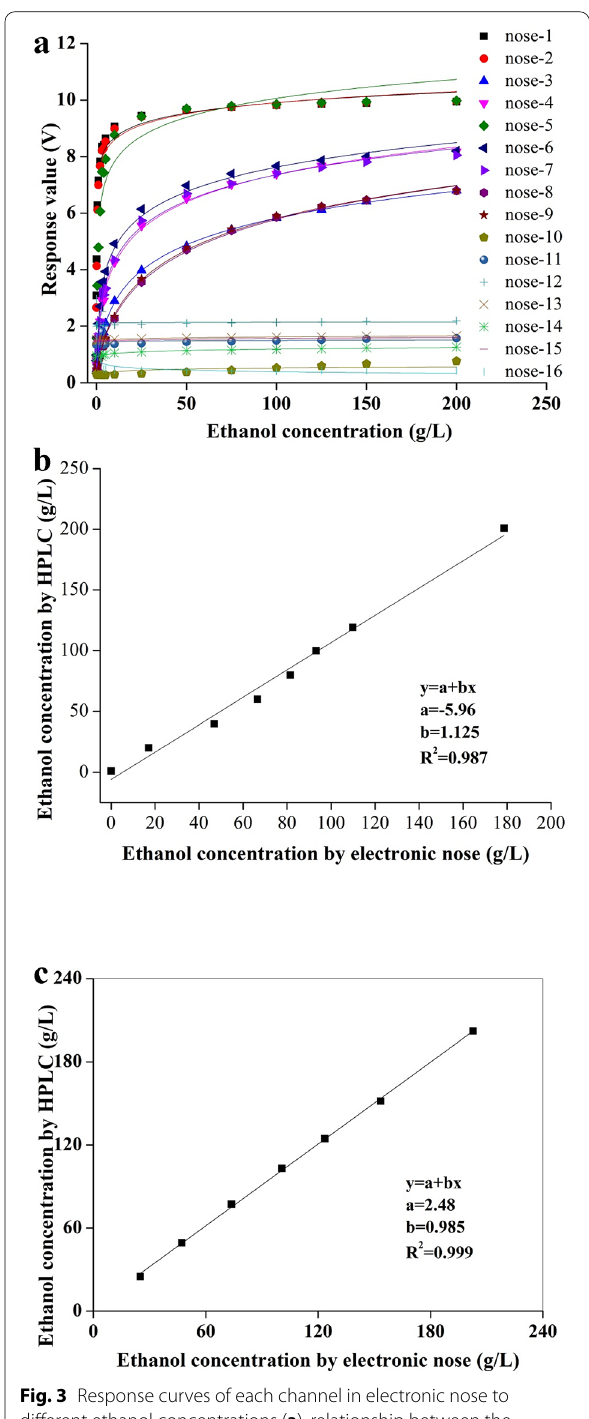
Fig. 3 Response curves of each channel in electronic nose to different ethanol concentrations ( a ), relationship between the ethanol concentrations determined by electronic nose and by HPLC. Channel 4 ( b ), Channel 3 ( c